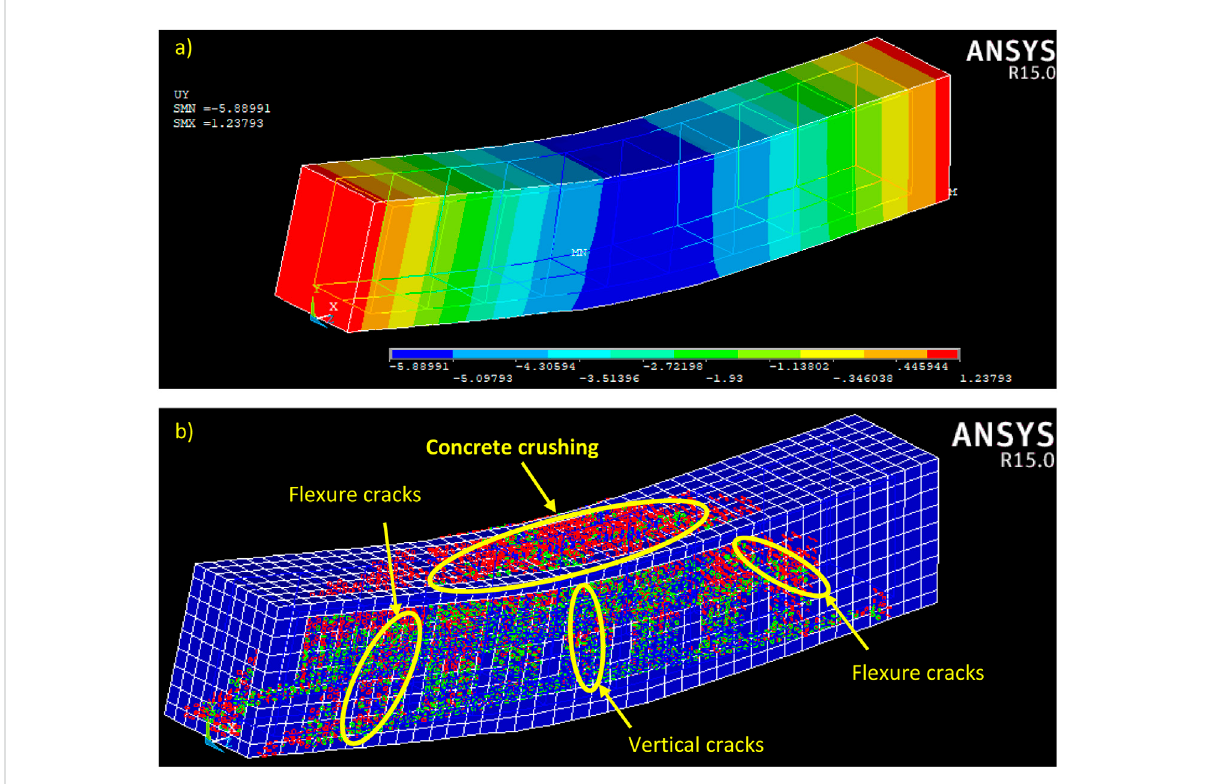
FIGURE 16 The 3D fi nite element analysis on concrete with 75% bottom ash shows results that may be seen on (A) contour plots, and (B) a view of the fractures in the RCB.